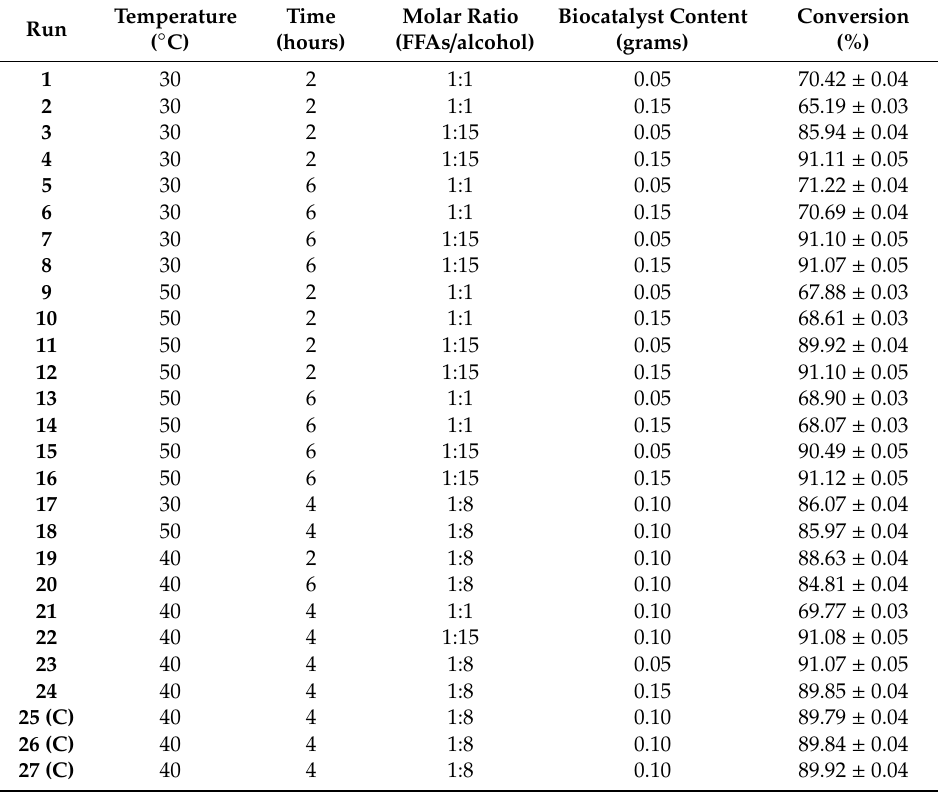
Table 4. Complete experimental design with 18 factorial points, 6 axial points (2 axial points on the axis of design variable) and 3 replications at the central point, totaling 27 experiments, with the result for the conversion into esters for the esterification of residual babassu